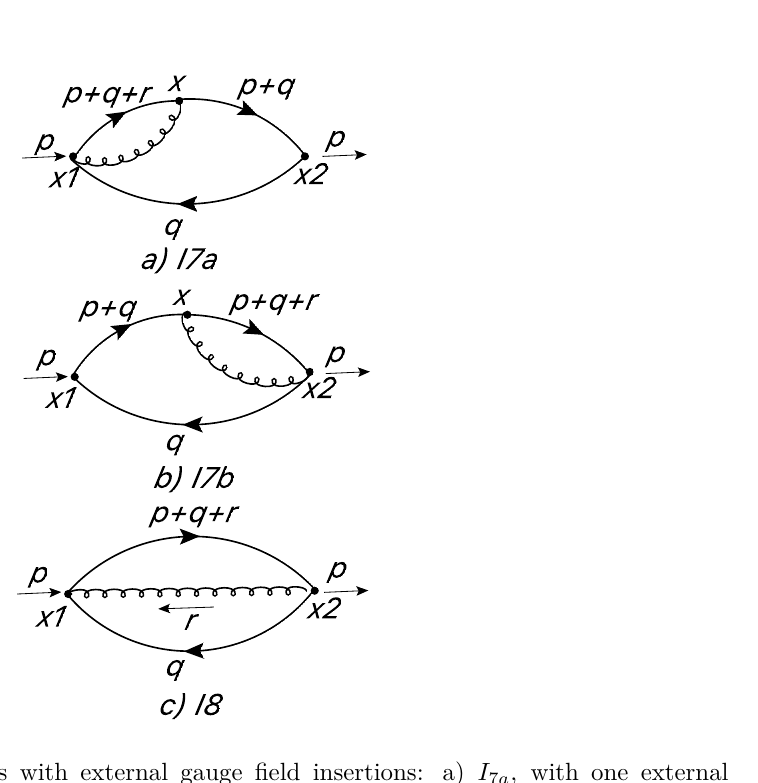
Figure 3 . Two-loop diagrams with external gauge field insertions: a) I 7 a , with one